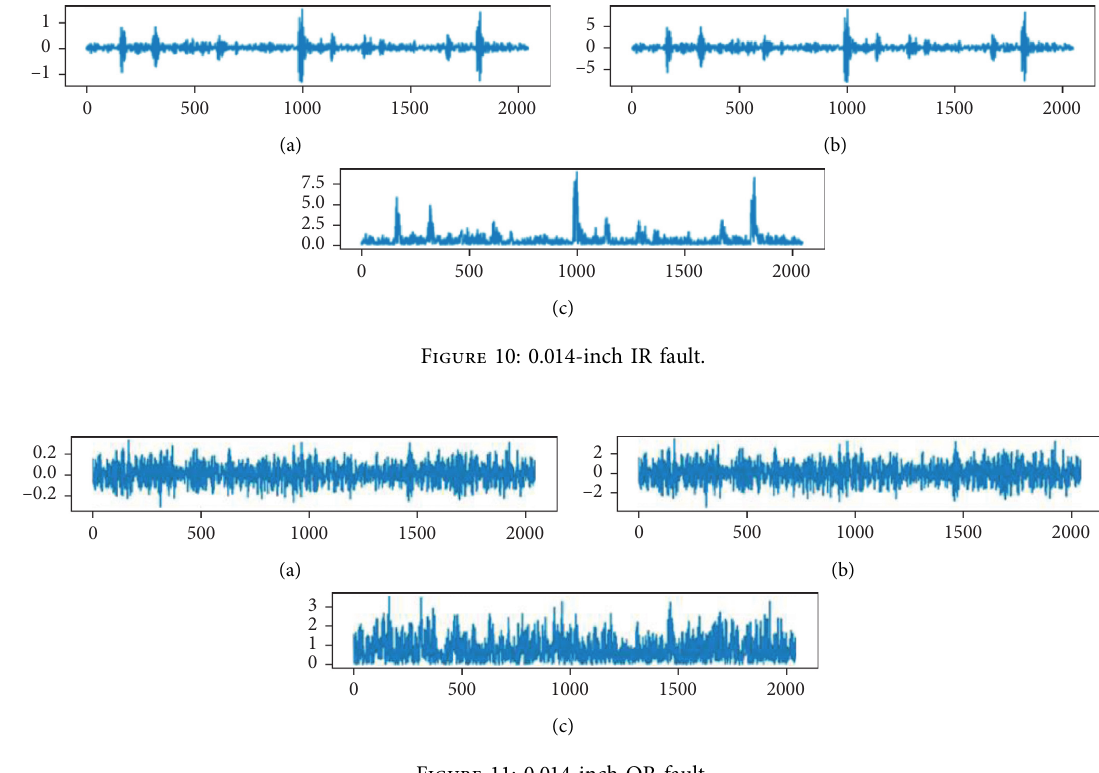
Figure 11: 0.014-inch OR fault.